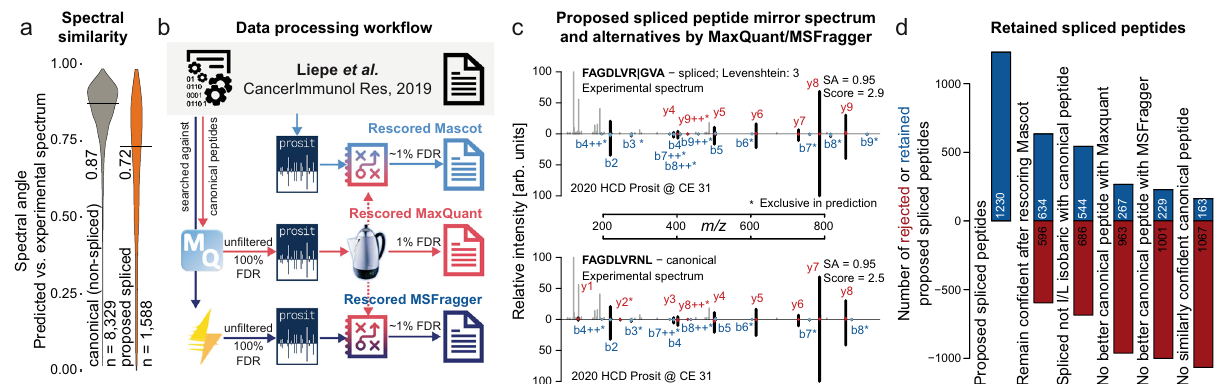
Fig. 4 Re-assessment of HLA peptides proposed to be generated by splicing. a Spectral angle distributions comparing HCD Prosit 2020